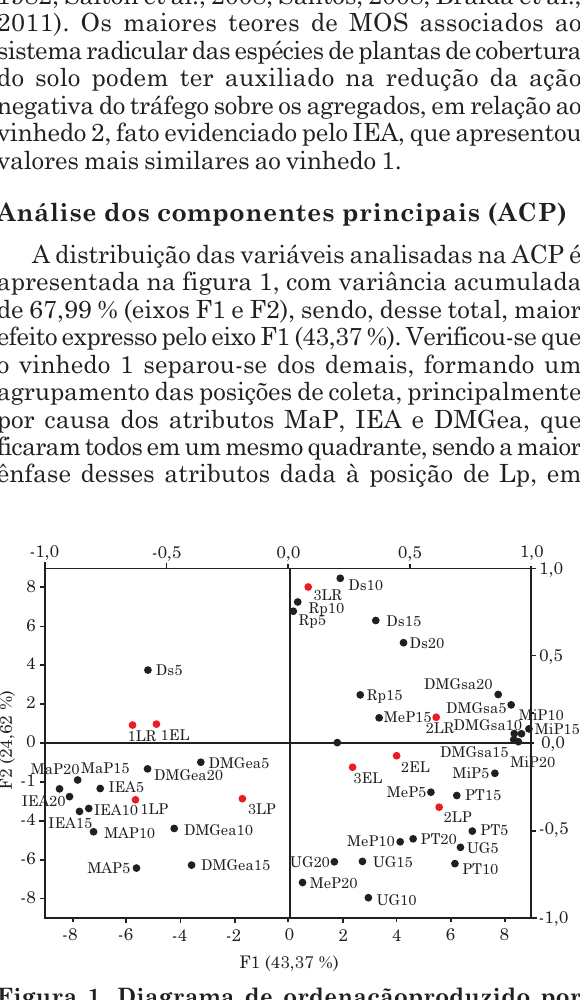
Figura 1. Diagrama de ordenaçãoproduzido por análise de componentes principais dos